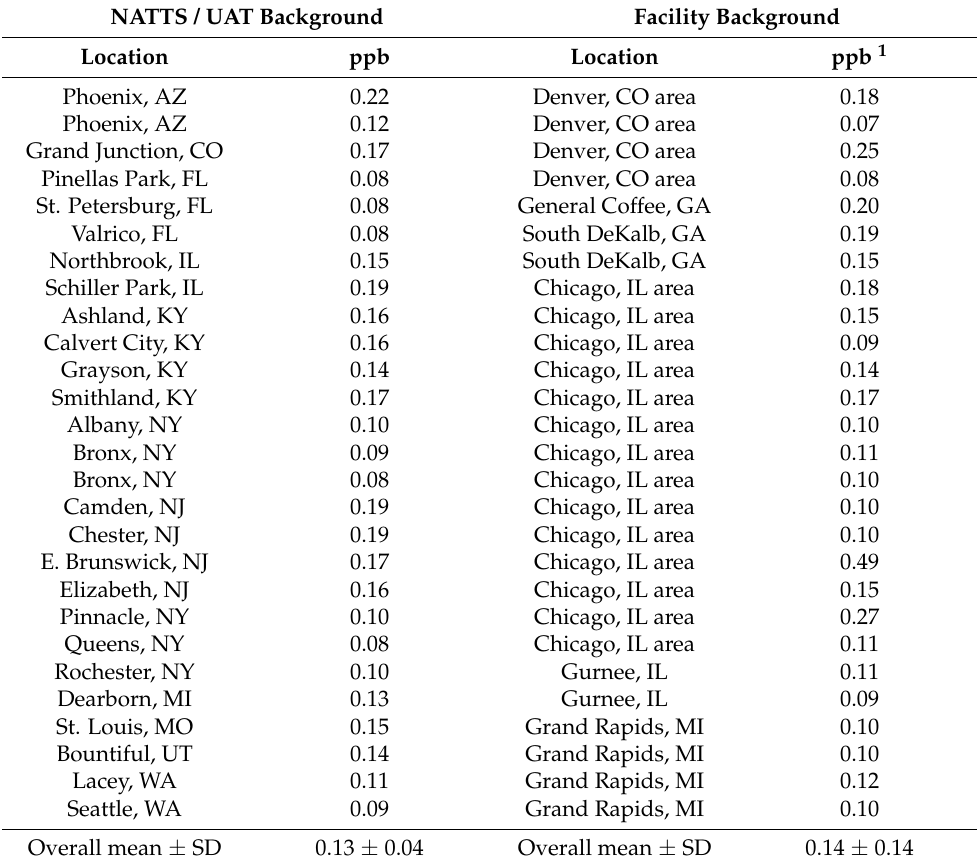
Table 4. Ambient air EO concentrations (ppb) at the NATTS and UAT locations (as reported by EPA in 2020 and summarized by ATSDR [5]) and at representative background locations associated with the eight EO-emitting industrial